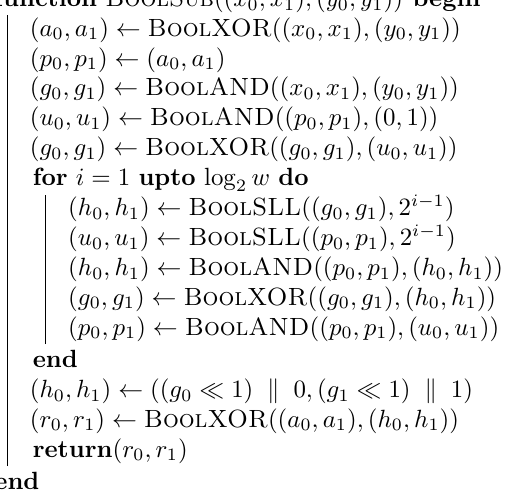
Algorithm 11: BoolSub : apply subtraction operation (under Boolean